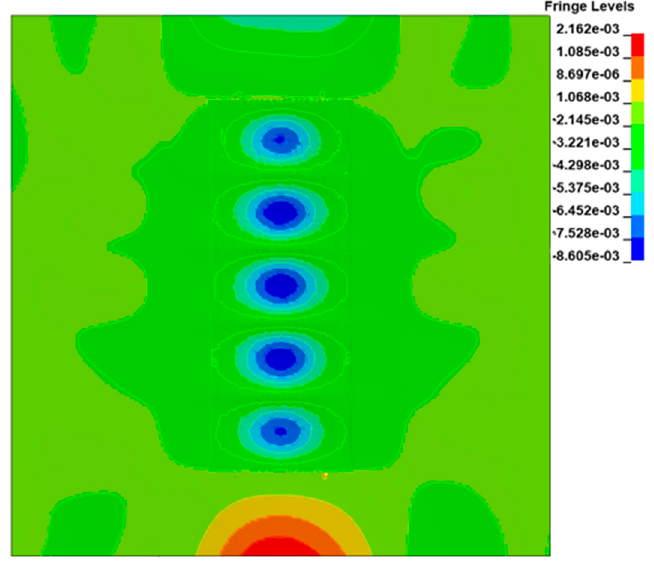
Figure 20. Dent distribution in the simulation (m).